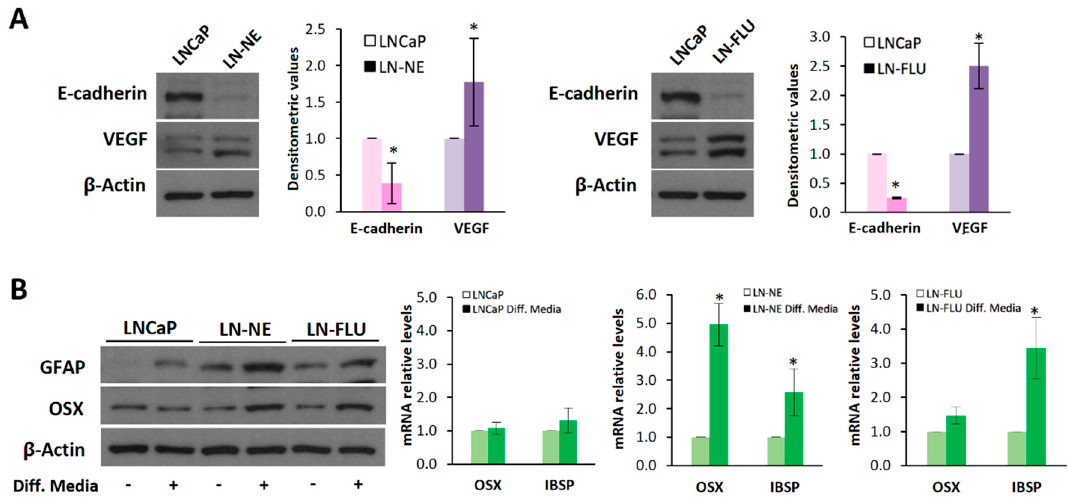
Figure 2. The prostate cell lines LN-NE and LN-FLU display phenotypic features of stem cells. ( A ) Levels of the epithelial marker E-cadherin and the proangiogenic factor VEGF in androgen-depleted cell lines determined by Western blot and limited to actin as a load control. A representative image of three experiments is shown. Densitometric analysis (n = 3) is shown on the right. ( B ) LNCaP, LN-NE, and LN-FLU cells were incubated in differentiation media for 15 days, and levels of the glial marker GFAP or the osteoblast marker Osx were determined by Western blot. Levels of expression of the osteoblast markers OSX and IBSP determined by qPCR. The data show the relative mRNA expression to GAPDH, which was used as a housekeeping gene. Data represent the mean ± SD of two independent experiments. * p < 0.05 significant difference between LNCaP and LN-NE cells or LNCaP and LN-FLU cells by two-way ANOVA and Sidak’s multiple comparisons test.